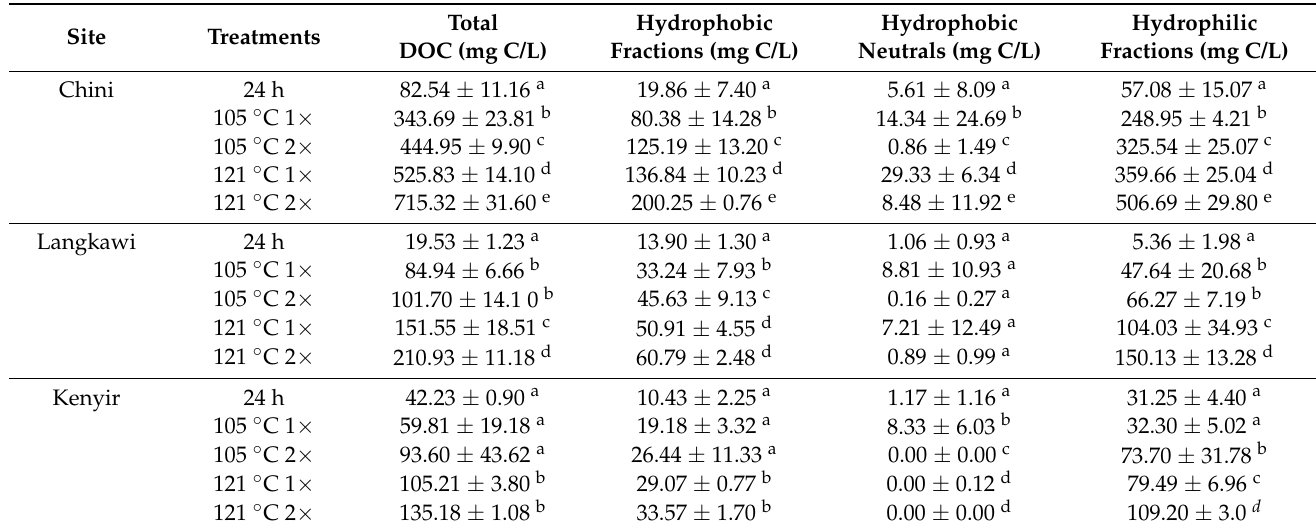
Table 4. Chemical characterization of dissolved organic matter fractions.